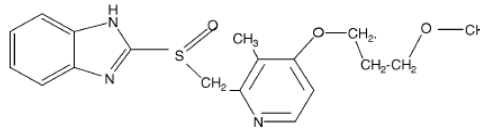
Figure 1. Structure of rabeprazole